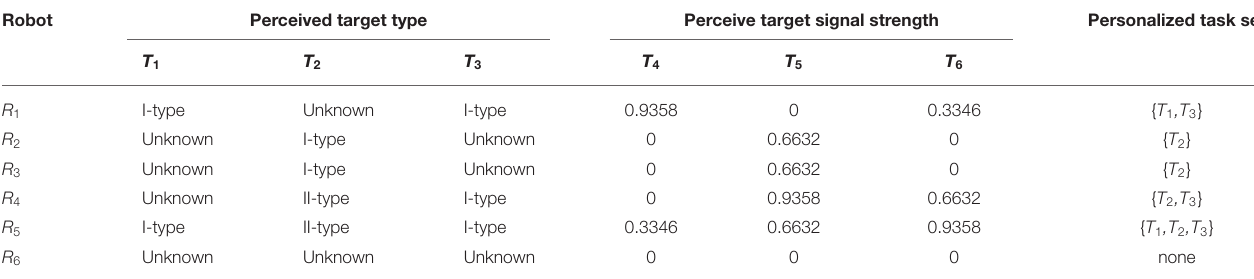
TABLE 1 | Detection of target signals by robots members at time t .